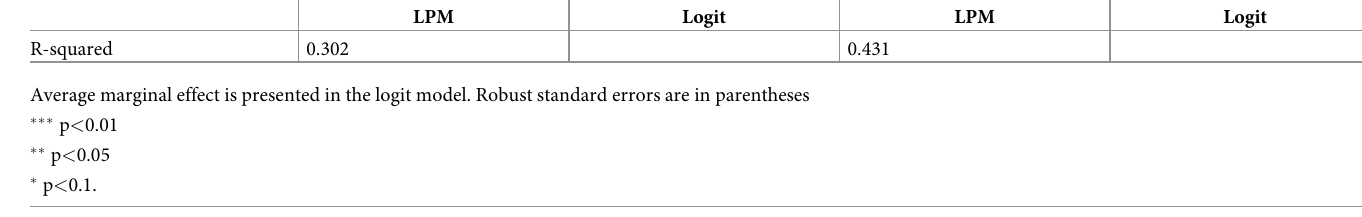
ever, in unfavorable environments risk reducing attributes of new technologies may be respon- sible for the major share of technology benefits and need to be accounted for in economic analyses [67]. CURE-related varieites explicitly focus on reducing yield losses under salinity exposure, with little or no penalty yield in other years and a small price penalty due to unfavor-